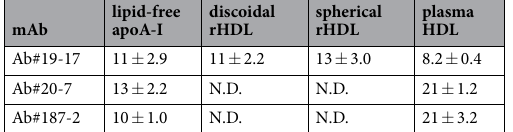
Table 2. K D values (nM) for sandwich ELISA shown in Fig.